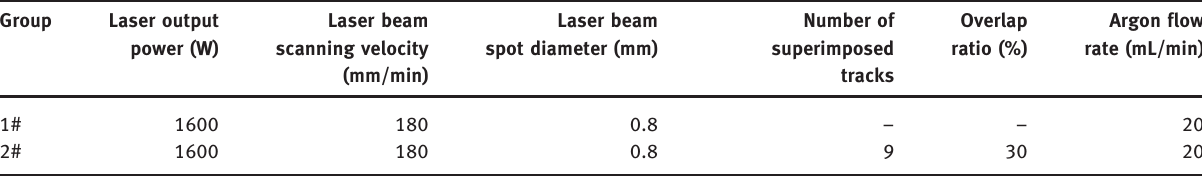
Table 4: Welding parameters. Group